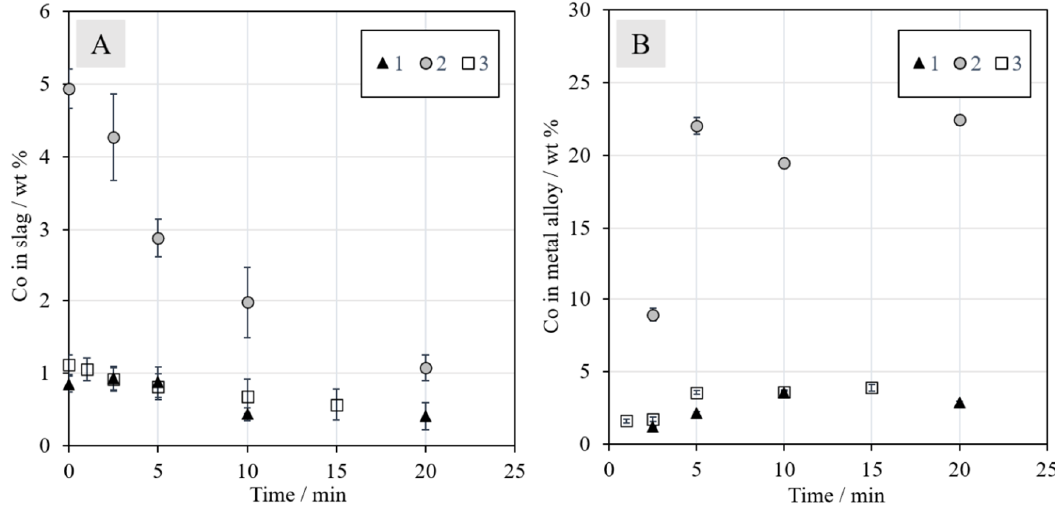
Figure 9. Concentrations (wt %) of cobalt in the ( A ) slag and ( B ) metal alloy as a function of time in N 2 + 5% CH 4 mixtures.